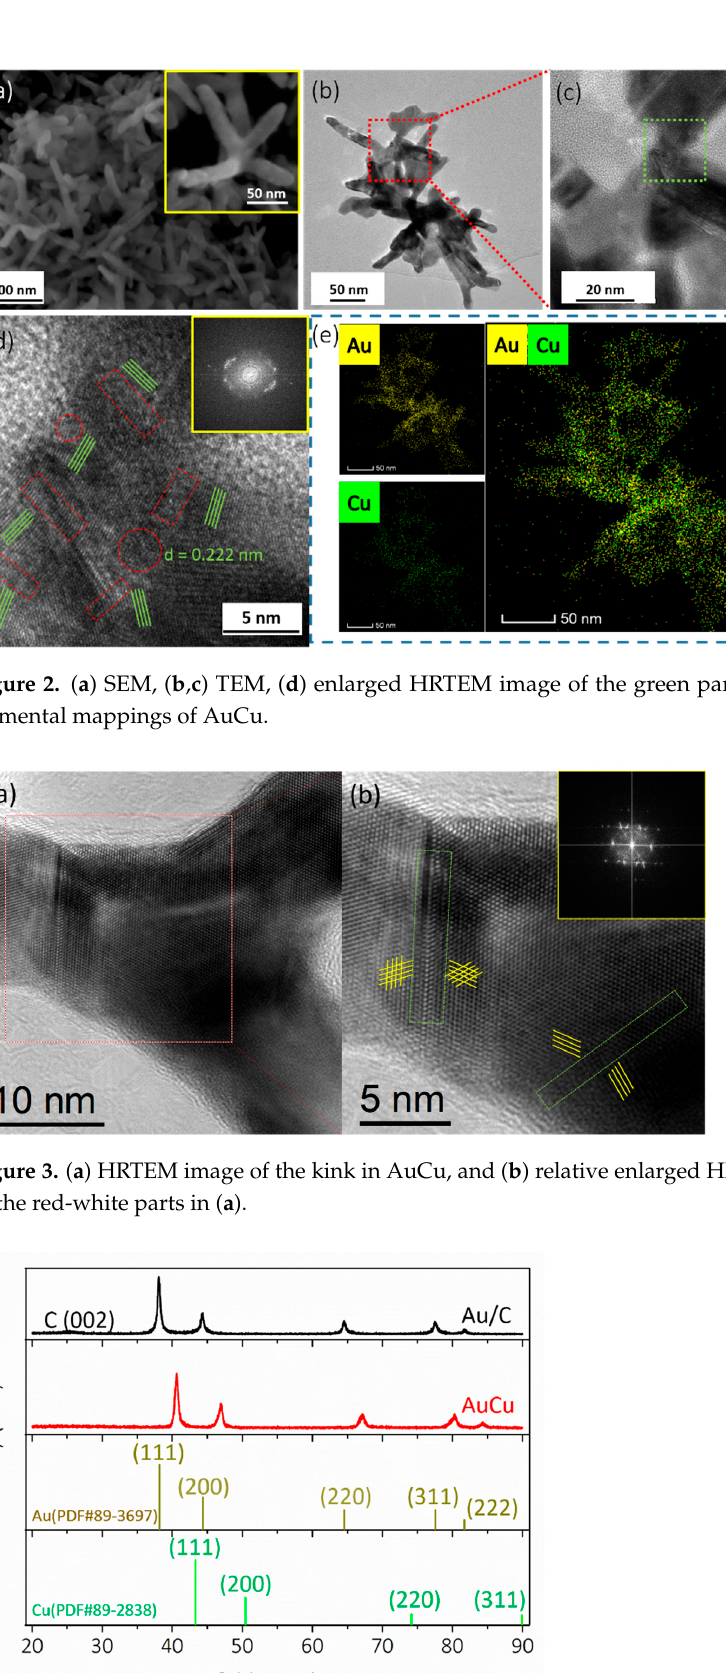
Figure 1. Schematic illustration of the preparation procedure of AuCu.